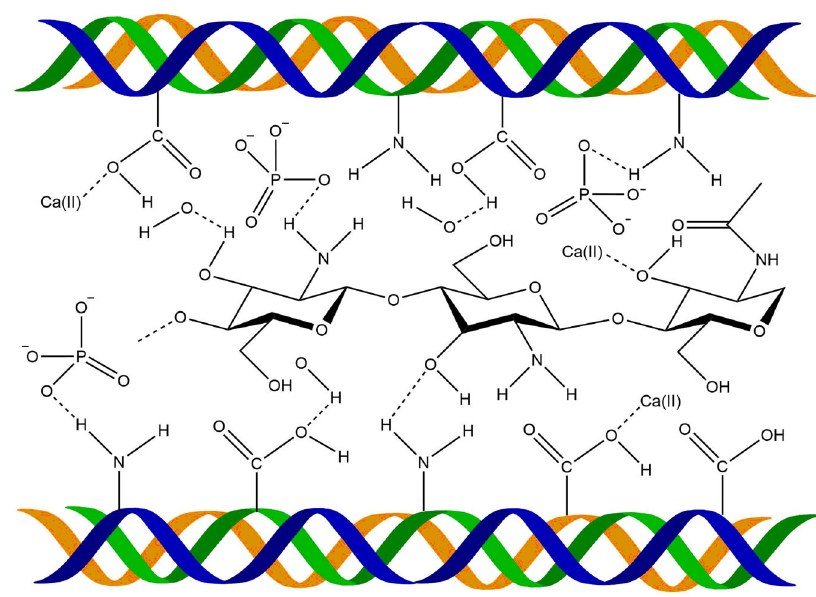
Fig. 10 Scheme of interactions collagen/chitosan/